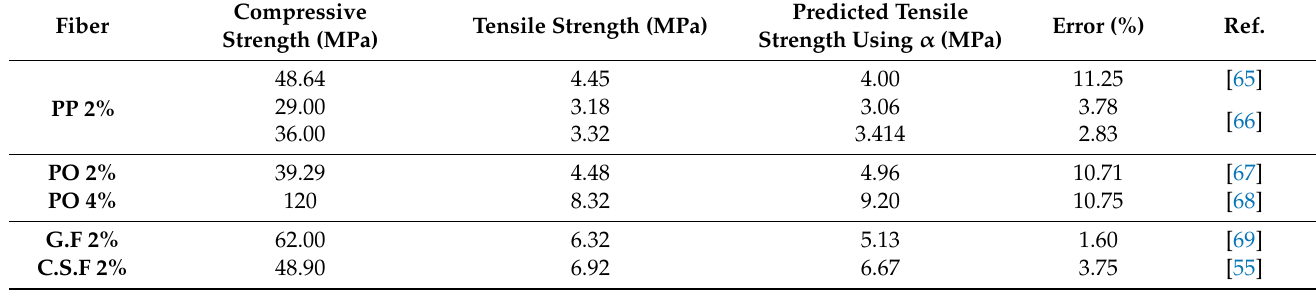
Figure 19. Relationship between tensile strength and compressive strength of FRC and ECC speci- men.